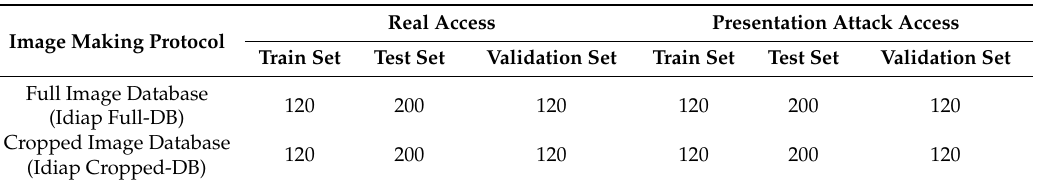
attack finger-vein image database with two protocols of full and cropped images.